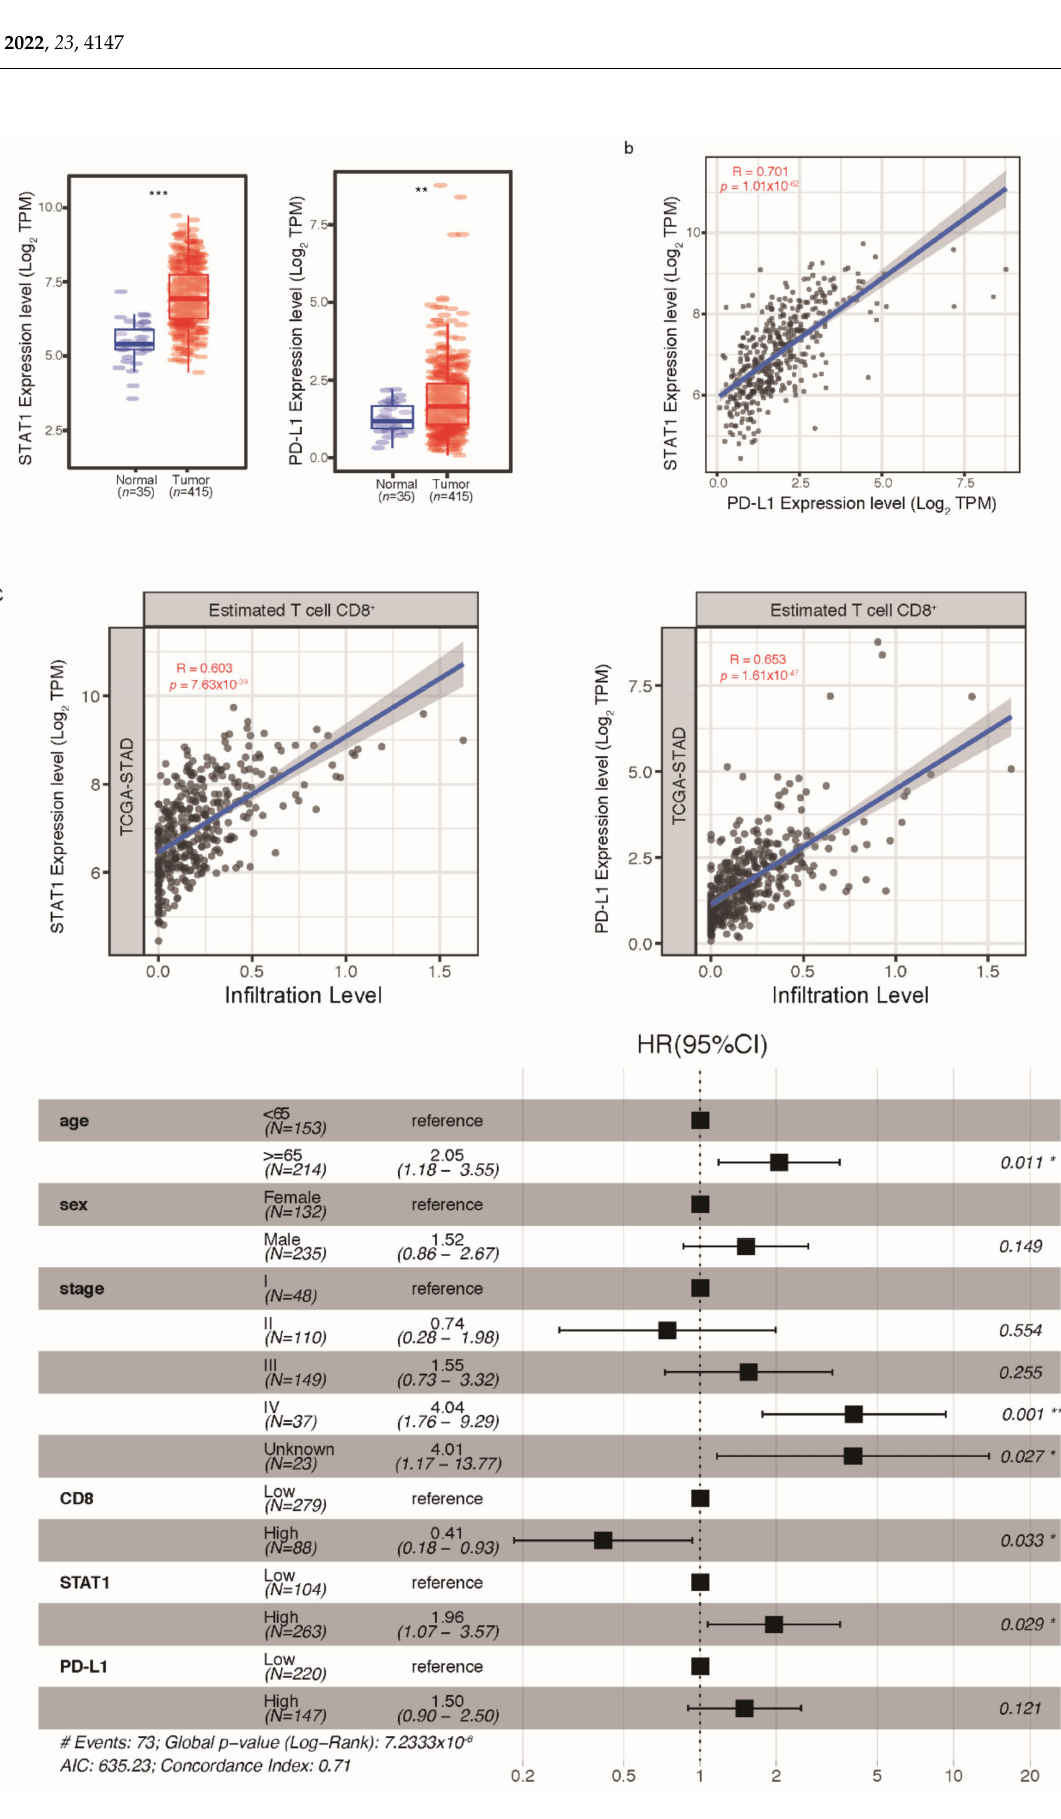
Figure 3. Transcriptome analysis of STAT1 and PD-L1 based on the TCGA-STAD database. ( a )